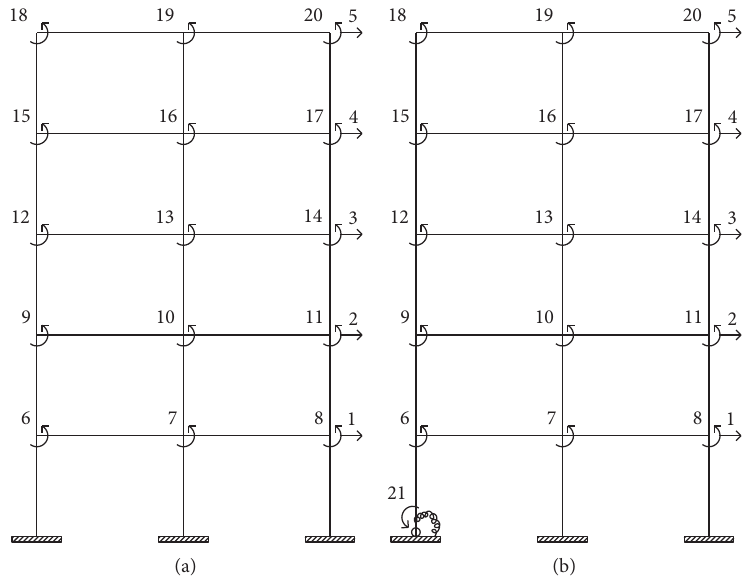
Figure 4: Degrees of freedom of the (a) undamaged and (b) damaged frame.